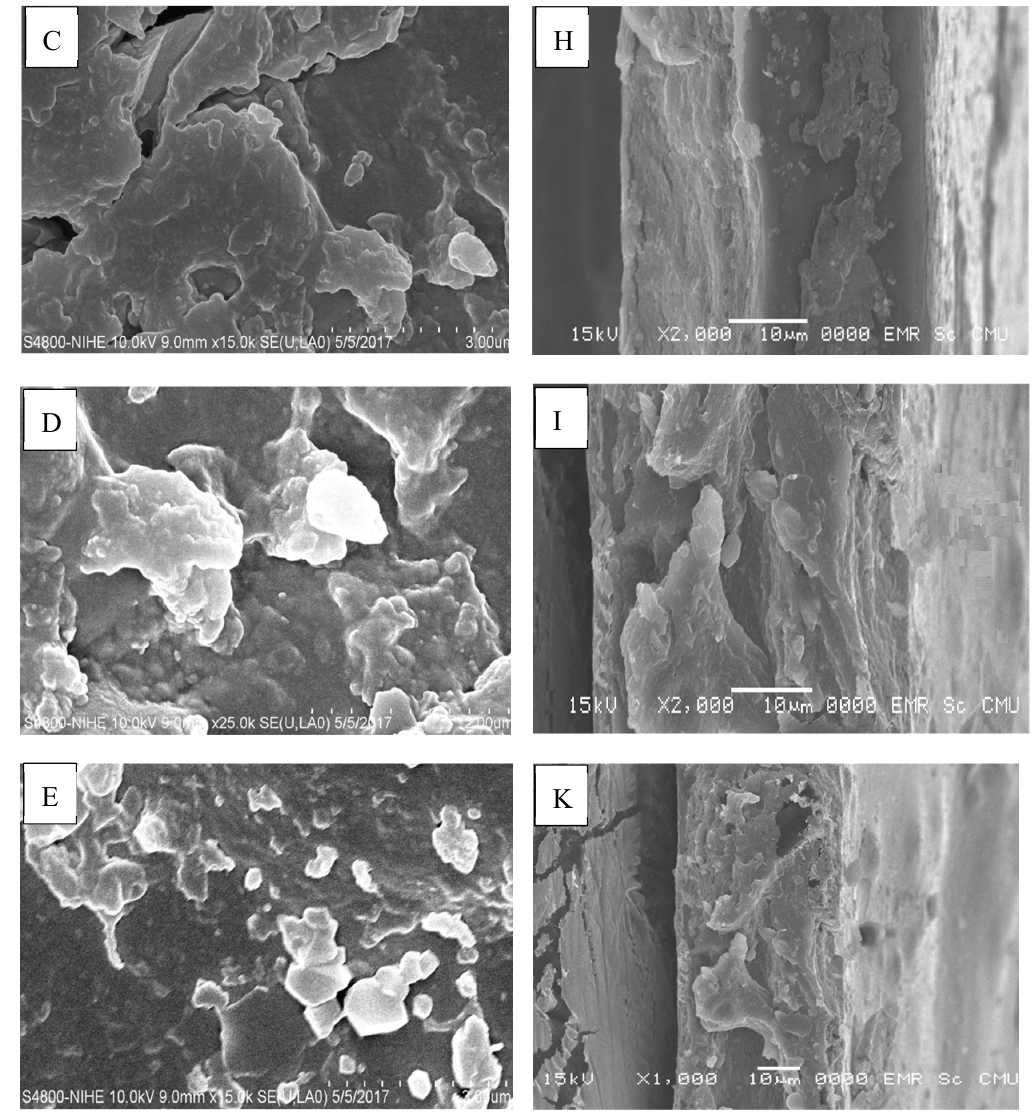
Figure 5. SEM images of surface of P, P:NCS 75:25, P:NCS 50:50, P:NCS 25:75, NCS films ( A – E , respectively) and SEM images of cross-section of P, P:NCS 75:25, P:NCS 50:50, P:NCS 25:75, NCS films ( F – K , respectively).